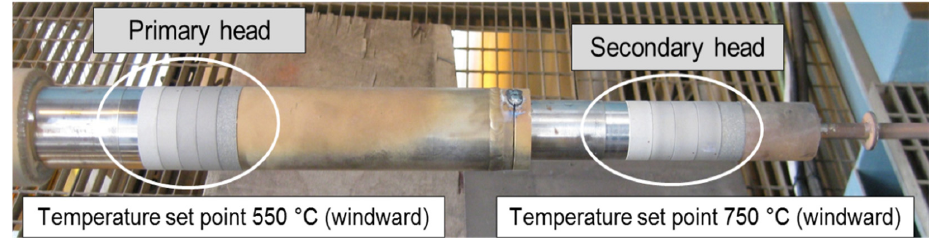
Figure 2. High temperature probe for corrosion testing at two temperature regions.